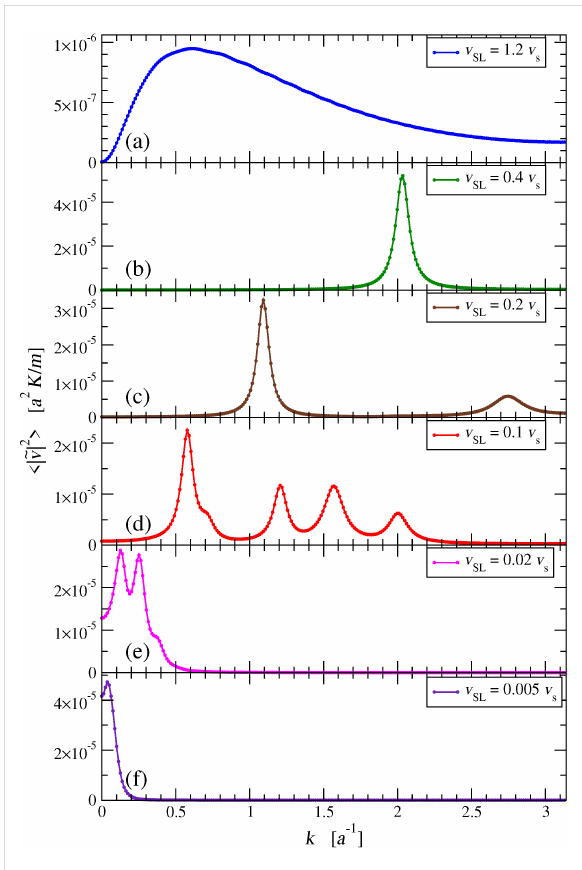
Figure 9: The time-averaged square modulus of the Fourier transform of the chain velocities, for a few characteristic values of v SL : (a) super- sonic speed; (b) single-peak subsonic region; (c) appearance of the second pair of peaks; (d) multi peak region near v SL 0.1 v s ; (e) small-speed collapse of the dissipation peaks toward k = 0; (f) full collapse to one peak at very small v SL v s